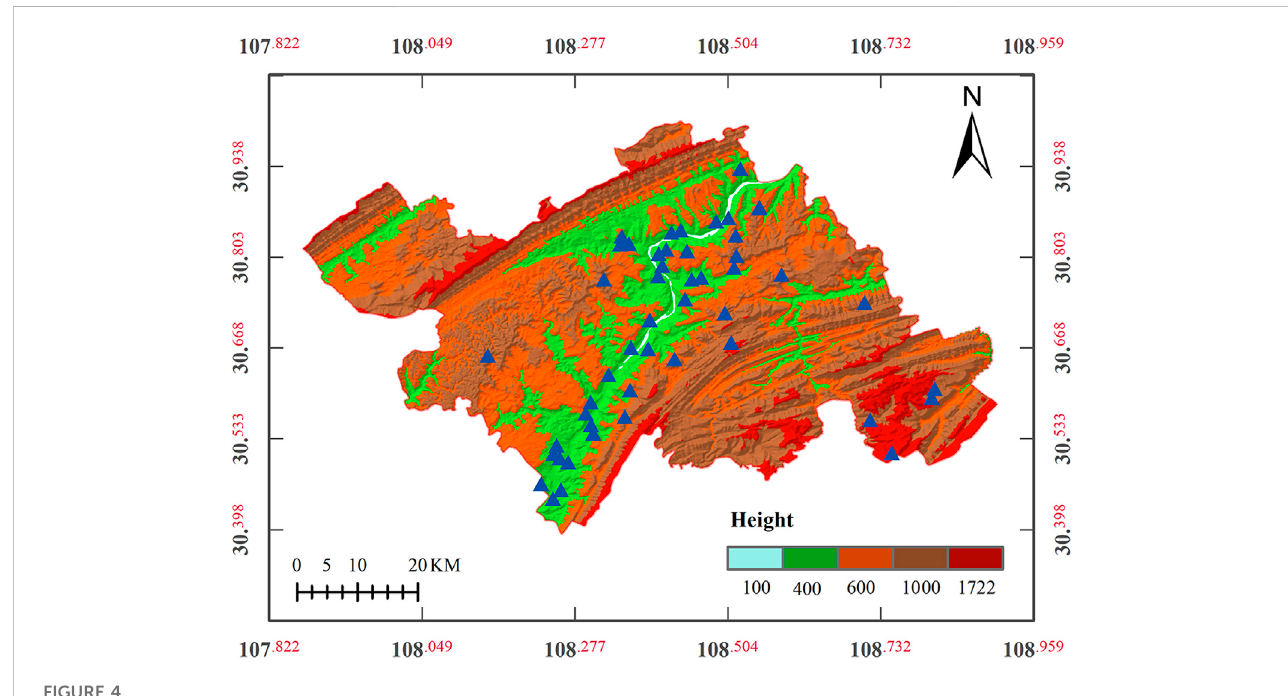
FIGURE 4 Locations of data points in Wanzhou